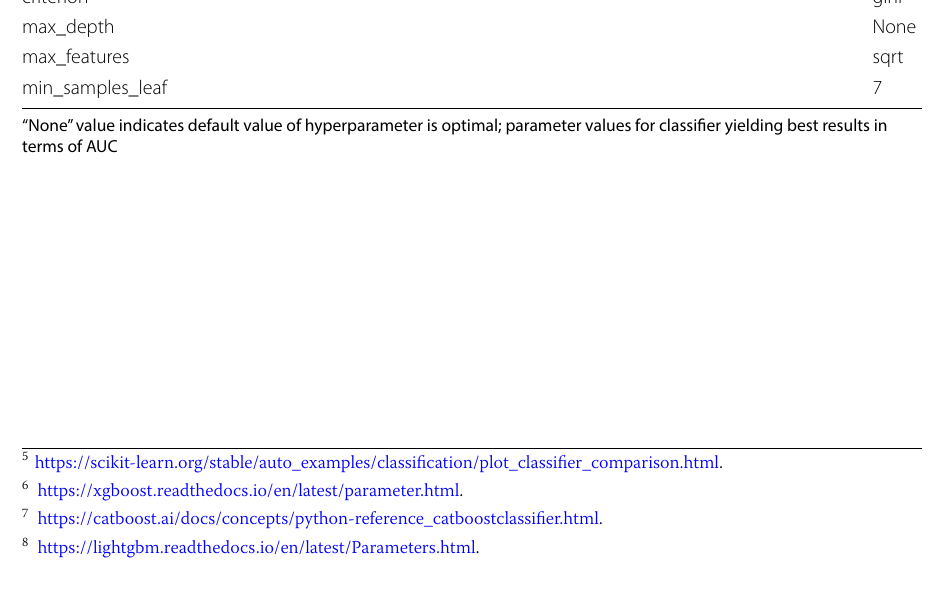
Table 60 Modes of DT tuned hyperparameter values for experiments with the theft dataset